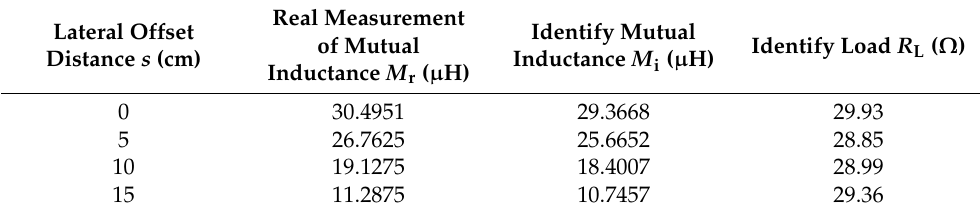
Table 4. Different mutual sense identification